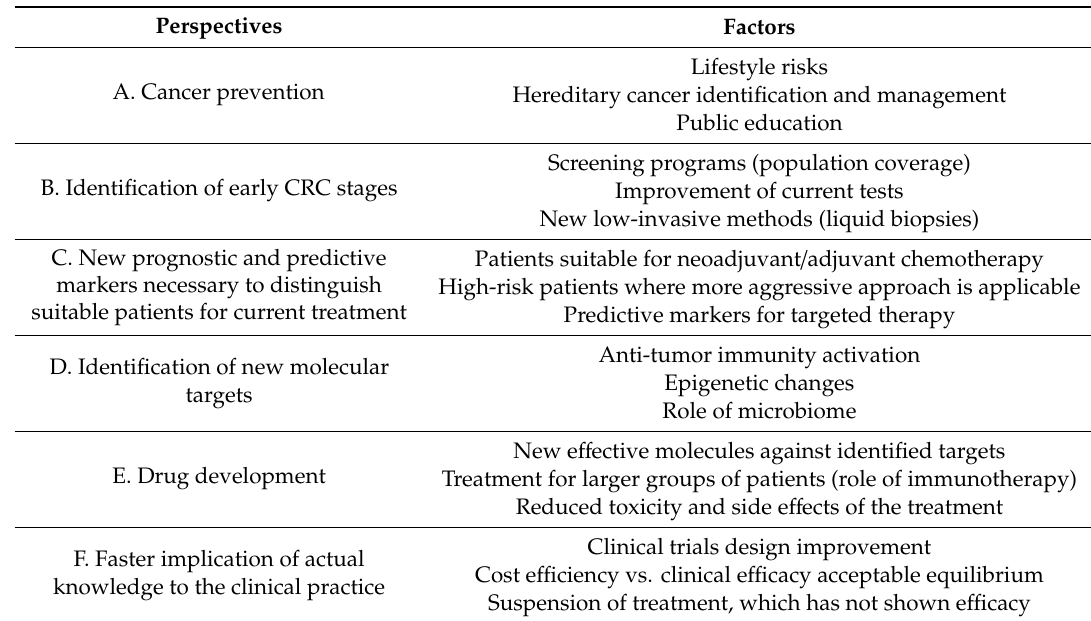
Table 2. Perspectives for colorectal